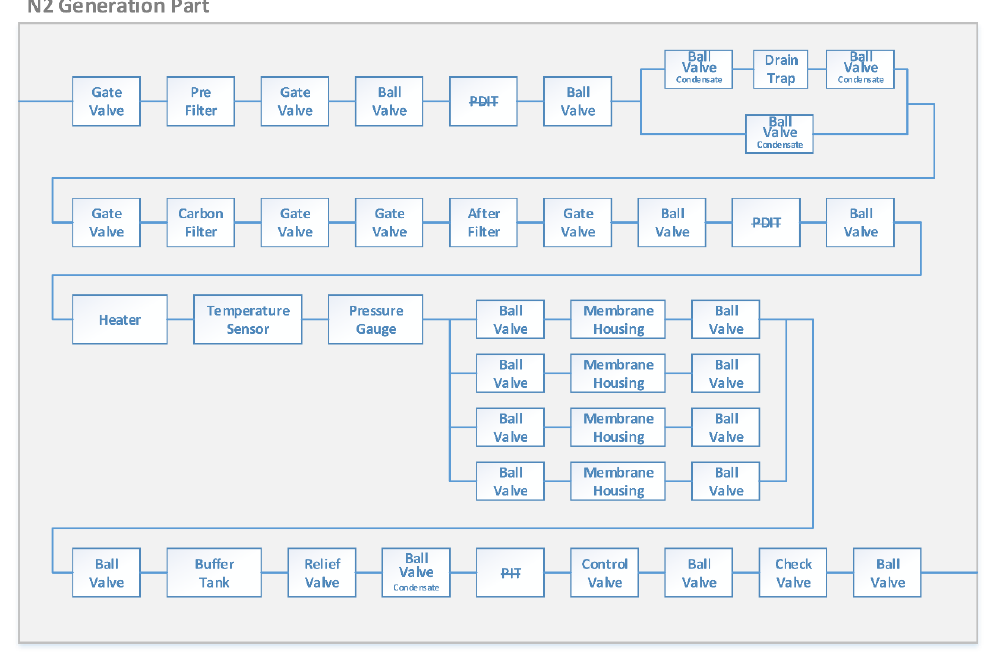
Figure 10. Reliability block diagram at Stage II (preliminary P&ID stage)—Nitrogen generation part.